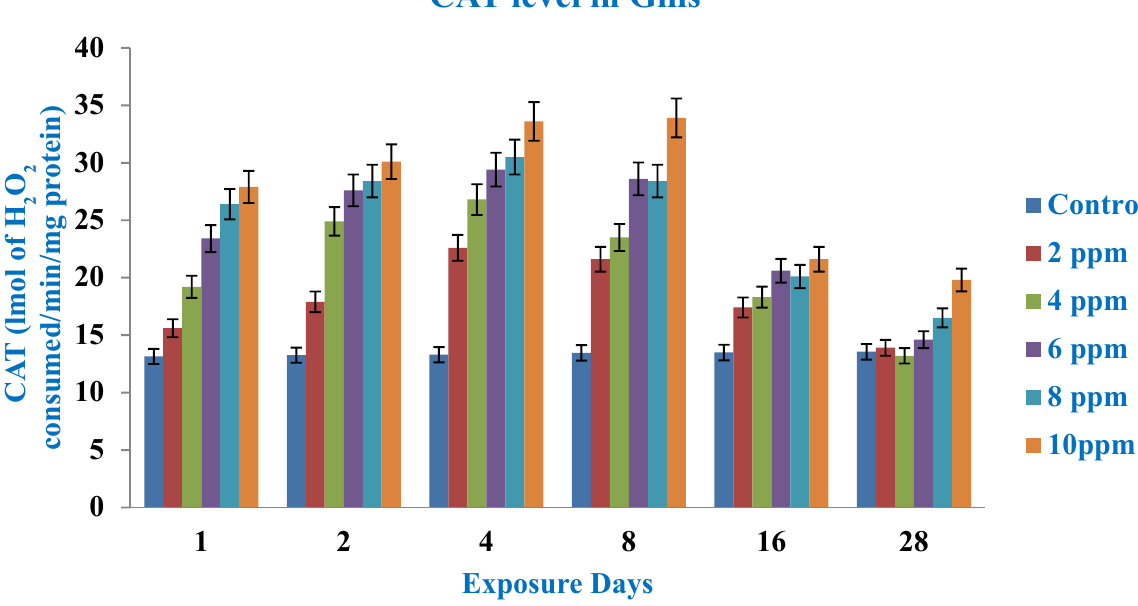
Figure 8. CAT enzymes in the gill region after the exposure (1–28 days) to AgNPs at different doses.